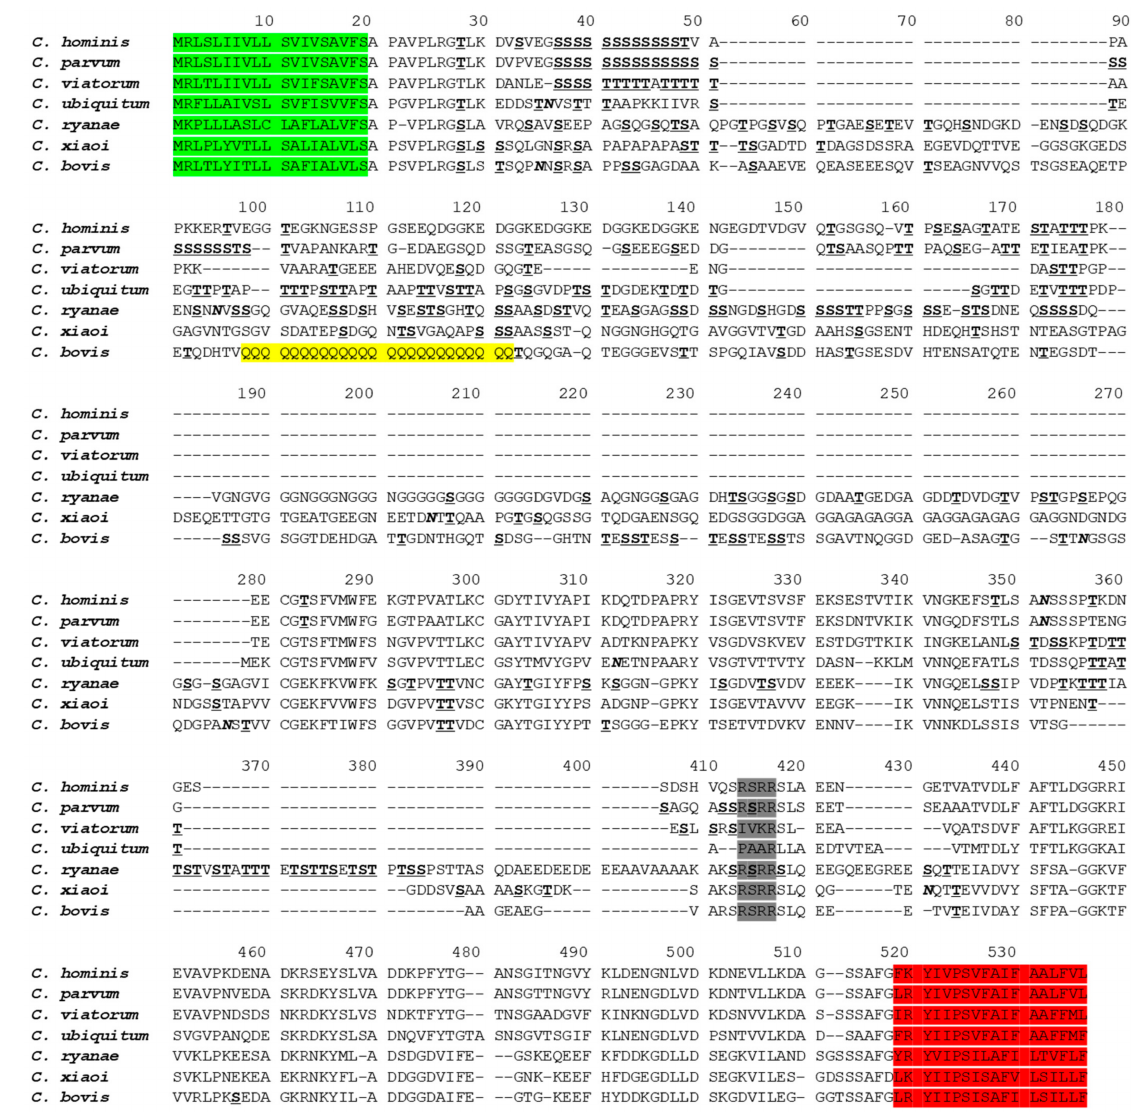
Figure 1. Alignment of the full GP60 sequence from Cryptosporidium bovis (this study) with those from C. hominis (ACQ82748), C. parvum (AAF78281), C. viatorum (AJP62575), C. ubiquitum (XP_028874367), C. ryanae [23], and C. xiaoi (QXJ78680). The signal peptide at the N-terminus and GPI anchor at the C-terminus are shaded in green and red, respectively. The putative furin cleavage site is shaded in gray. Potential N-linked glycosylation sites are marked in bold and italics, and O-linked glycosylation sites in bold with underline. The unique polyglutamine tract in C. bovis is highlighted in yellow. Dashes indicate amino acid